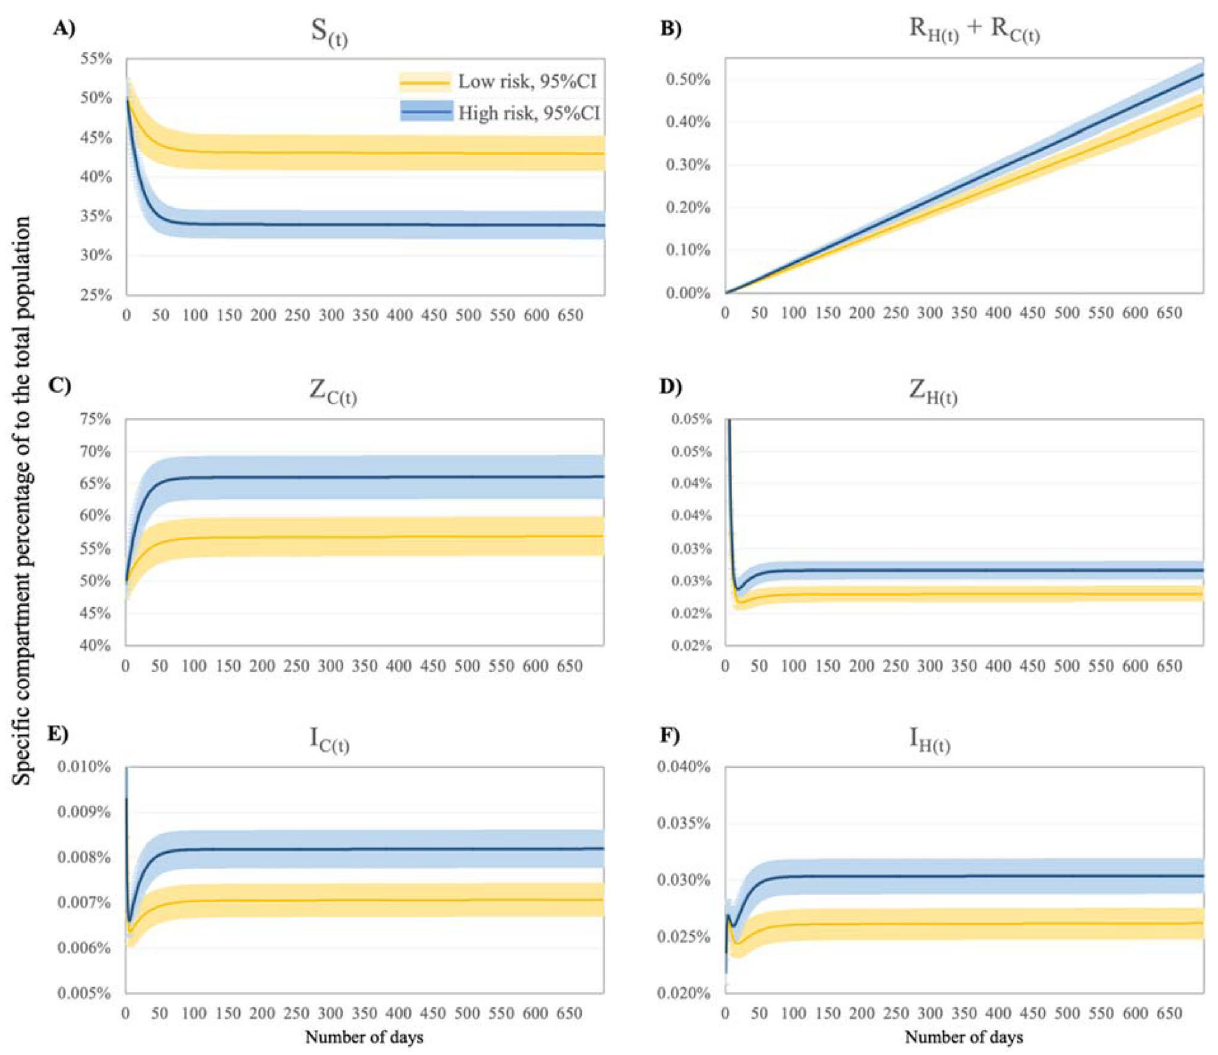
Figure 3. Proportion of the population (N) per compartment and overtime, by risk group. Notes: All groups coloured in light blue (or dark) sum up 100% of the population (N) including those removed. The proportions were calculated from the main model over the end of the study period (also see Fig. D5, supplementary material). S: Susceptible population, Z C : Colonised individuals by a GN-ARB in the community; R C : Individuals removed (dead due to GN-ARB BSI in the community); R H : Individuals removed (dead due to GN-ARB BSI in the hospital). I H : Individuals with a GN-ARB BSI in the hospital, that is comprised of I HH : Individuals with a hospital-acquired GN-ARB BSI; I HC : Individuals with a community-acquired GN-ARB BSI; I H : Individuals with a GN-ARB BSI in the community; Z H : Colonised individuals by a GN-ARB in the hospital. Figure D5.2 (supplementary material) shows the proportion of the total population by compartment and risk scenario at the end period. Y-axes stand for each specific compartment proportion to the total population (e.g., the y-axis in panel A stands for the proportion of the total population consisting of